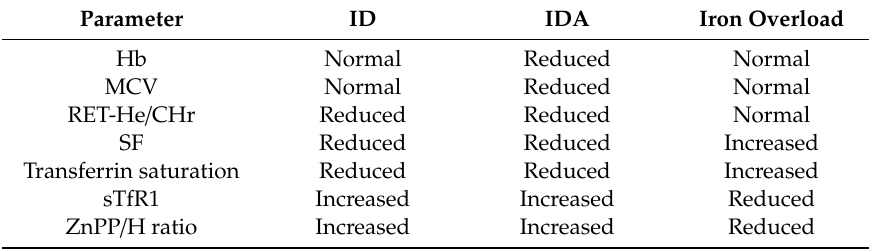
Table 1. Iron status parameters: their response to ID, IDA and iron overload [14,54,55]. Parameter ID